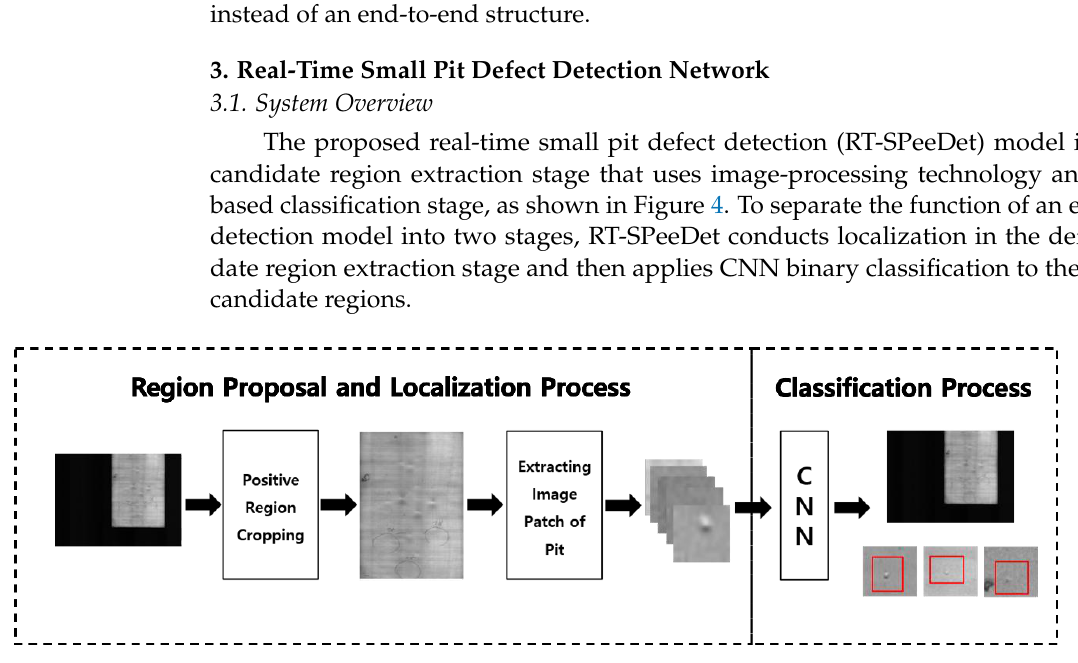
Figure 4. Diagram of IP – CNN-based RT-SPeeDet system.